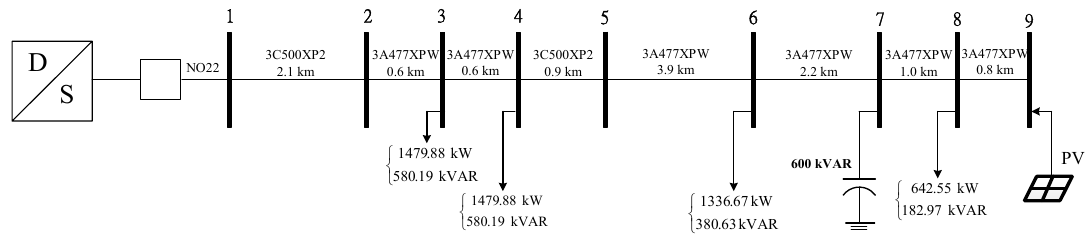
Figure 3. One-line diagram of an 11.4 kV distribution feeder in a Taipower system.